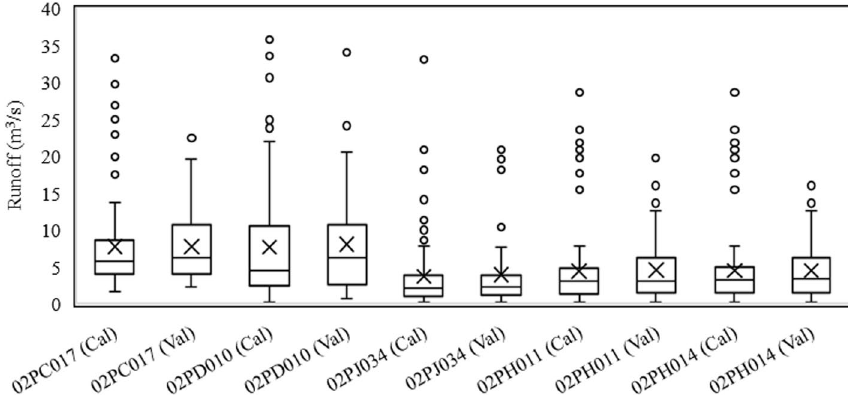
Fig. 2 Statistical analysis of the runoff time series for all stations in calibration and validation